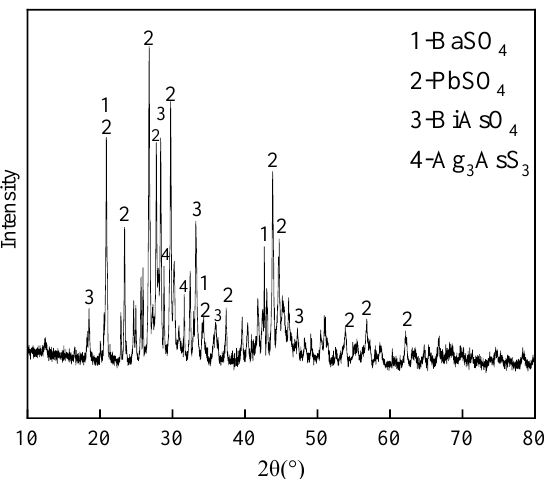
Figure 3. Effect of time on the leaching of each element (T = 150 °C, P = 0.8 MPa, H 2 SO 4 = 100 g/L).